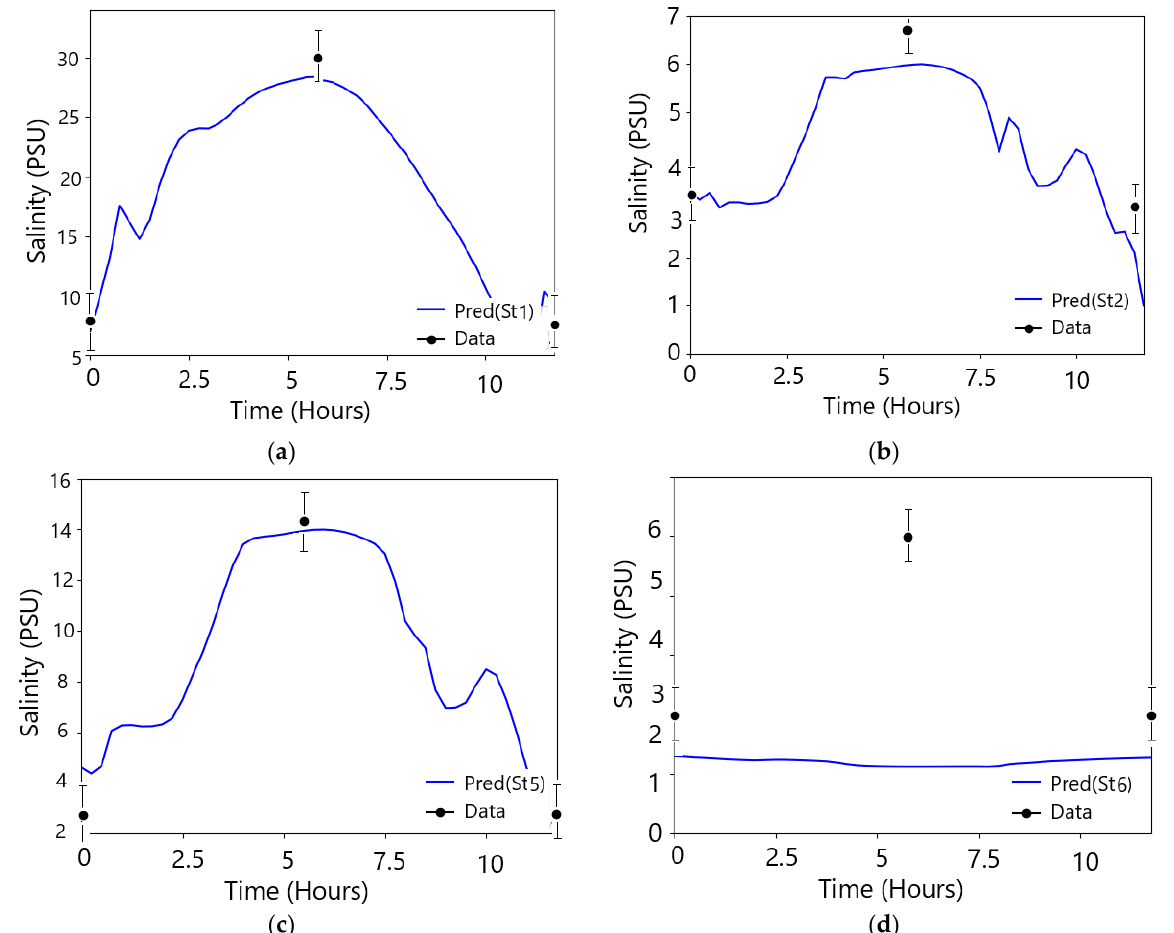
Figure 5. Simulation (line) and data (dot) for the salinity ( a ) — St1; ( b ) — St2(b); ( c ) — St5; ( d ) — St6.